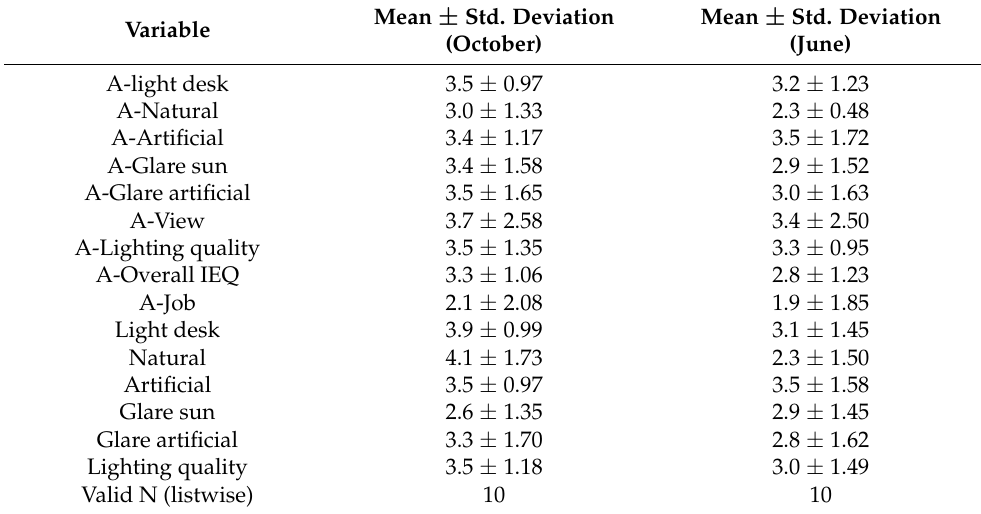
Table 6. Descriptive statistics analysis of all 15 satisfaction variables (1 = very satisfactory, 7 = very unsatisfactory) of the first POE in October ( N = 10) and the second POE in June ( N = 10) of within-subjects study.